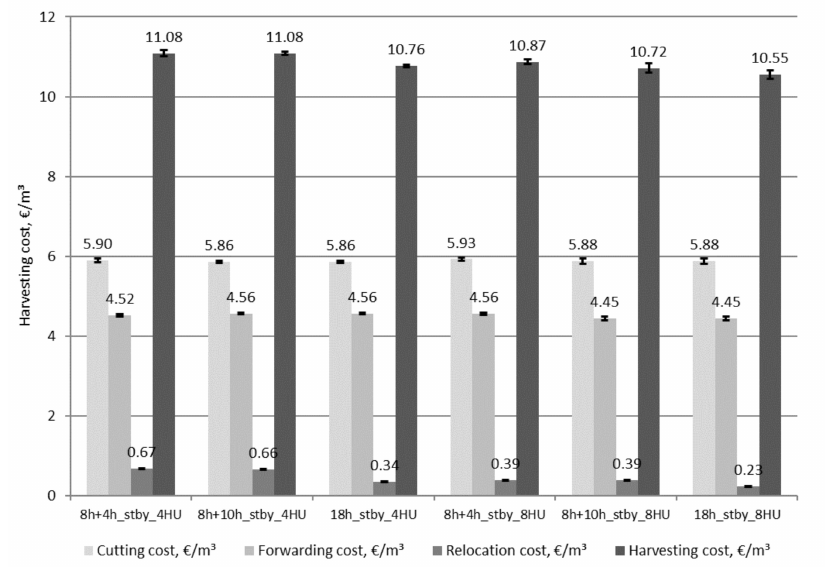
Figure 15. Harvesting costs for the scenarios with alternative relocation options for the 4 and 8 HU fleet sizes. The 8h+4h-stby consisted of the 8 h work shift of a relocation truck driver added to a 4 h standby mode managed by the harvesting entrepreneur’s head personnel. The 8h+10h- stby and 18h-stby consisted of an 18 h readiness for relocations. Error bars represent 95% CI of 7 scenario